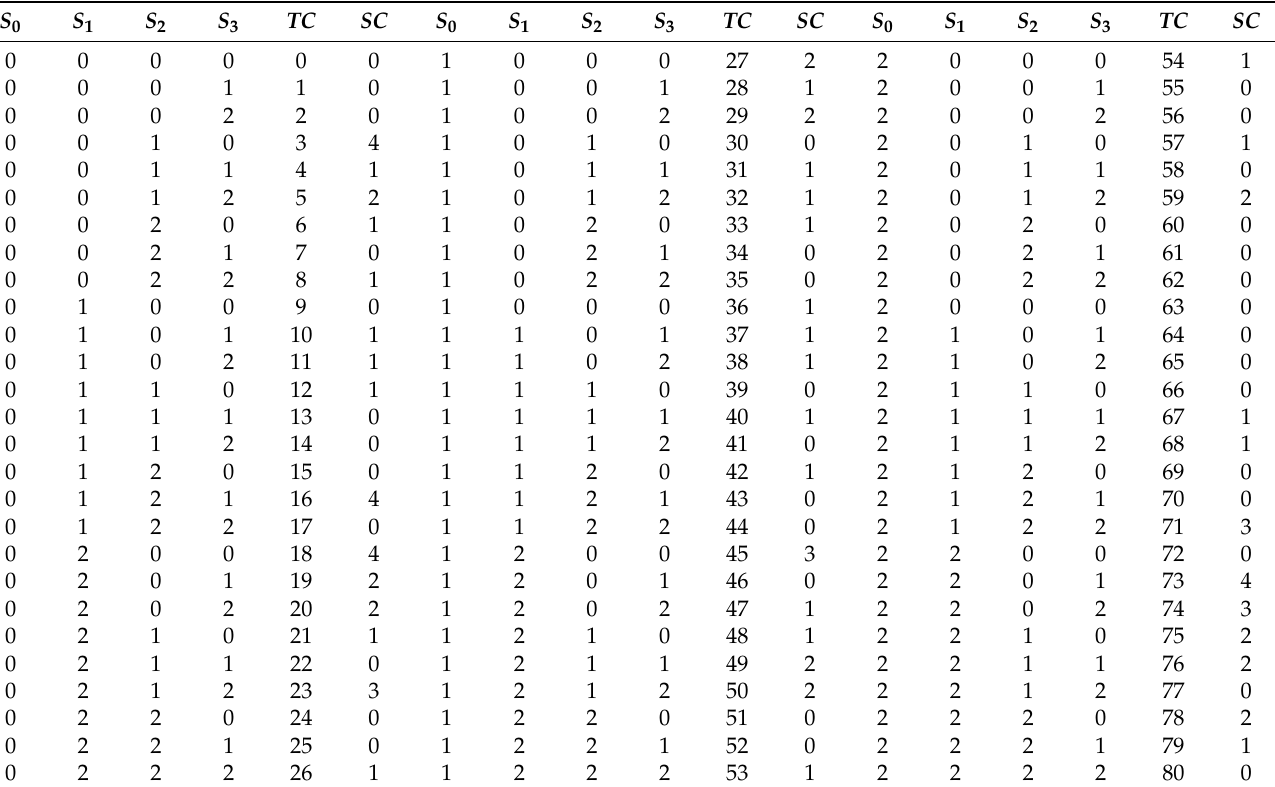
Table 2. CTX table for translating ternary context TC values into sign context SC